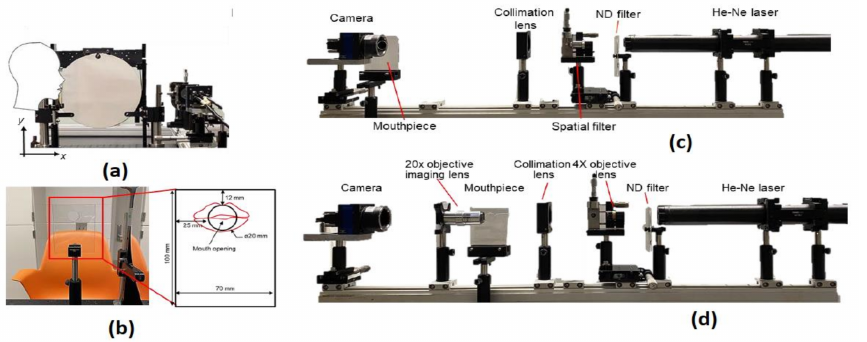
Figure 35. ( a ) The head position of the participant. ( b ) Breathing direction of the participant. ( c ) 1 × DIH measurement system. ( d ) 20 × DIH measurement system. Figure adapted with permission from